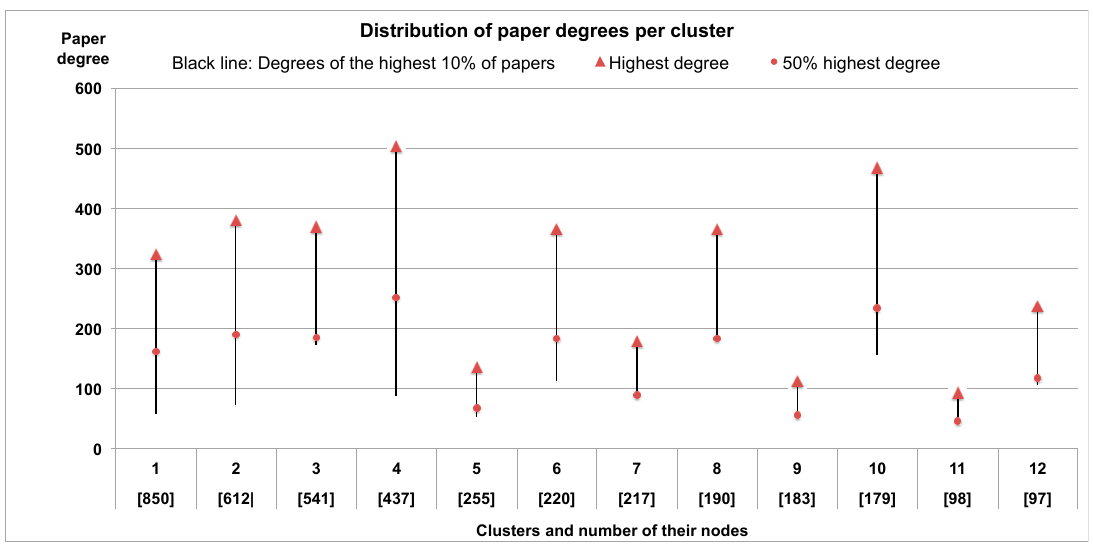
Figure 3. Relationship of the degrees of the analysed papers within the 12 main clusters compared to all papers within a cluster.